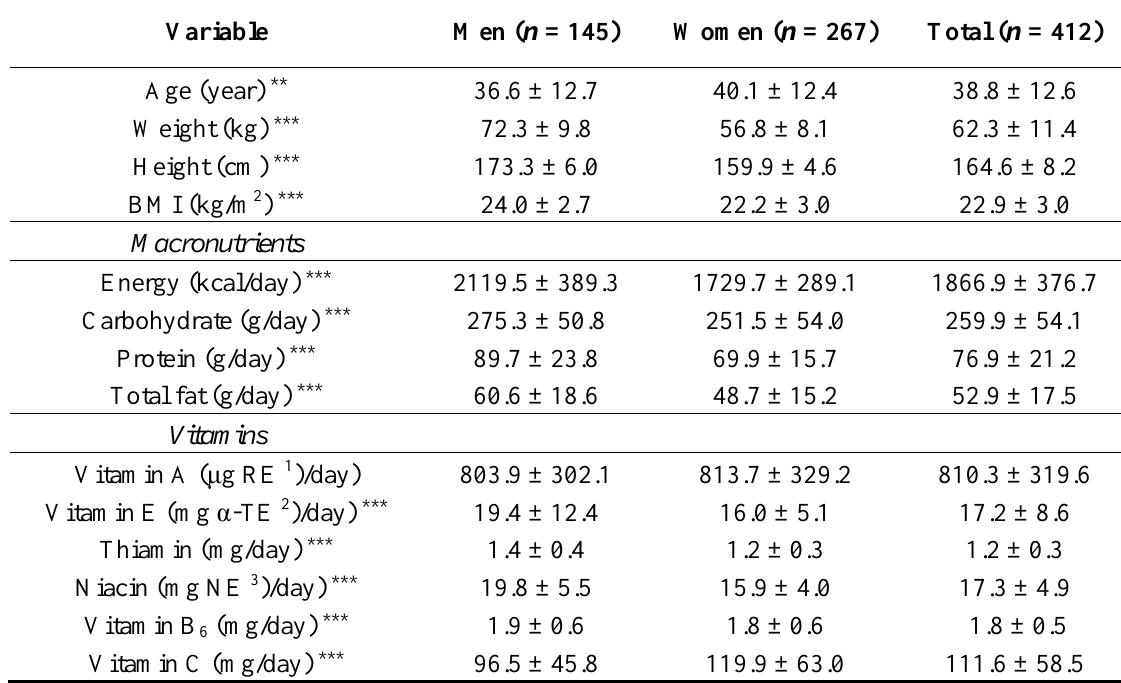
Table 1. General characteristics and selected nutrient intakes of 412 Korean adults by